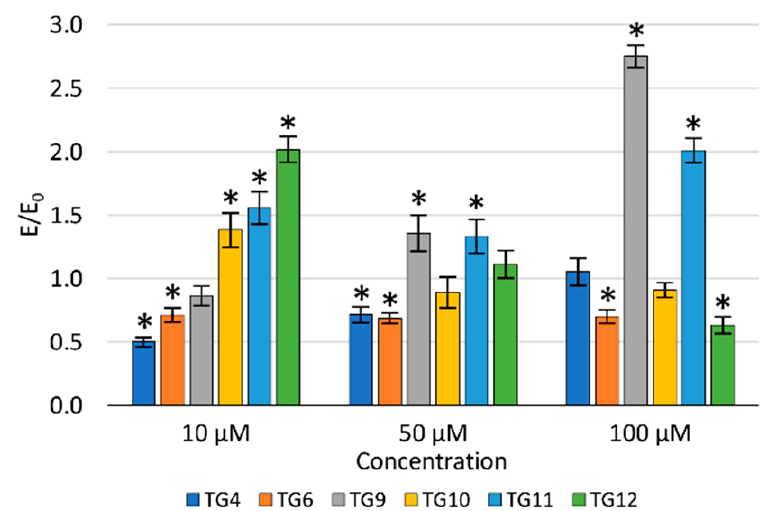
Figure 5. The effect of the tested compounds on the number of DNA double-strand breaks in TC28a2 cells; * p < 0.05—significant difference compared to the control.